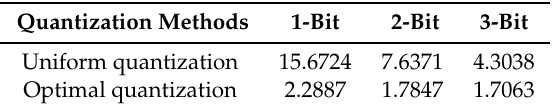
Table 2. Average tracking errors of two schemes with different data